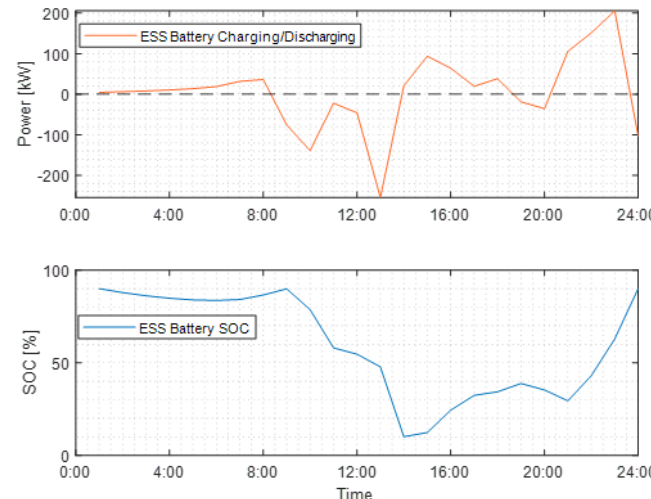
Figure 10. ESS operation at XFC4 on a winter’s day.